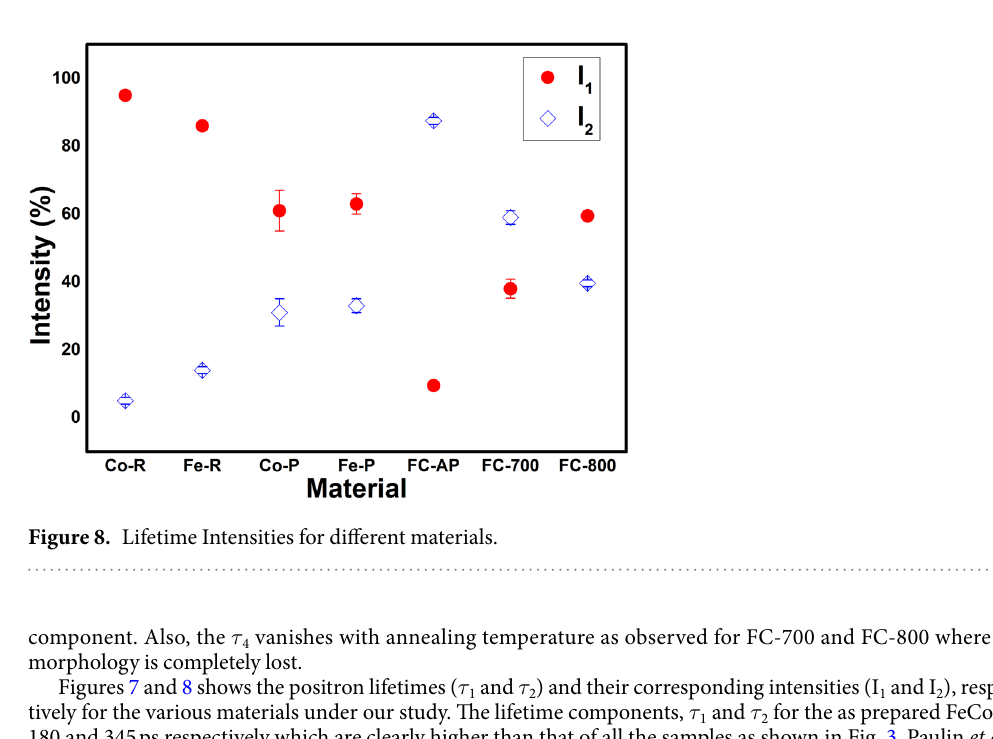
Figure 7. Positron lifetimes for different materials.